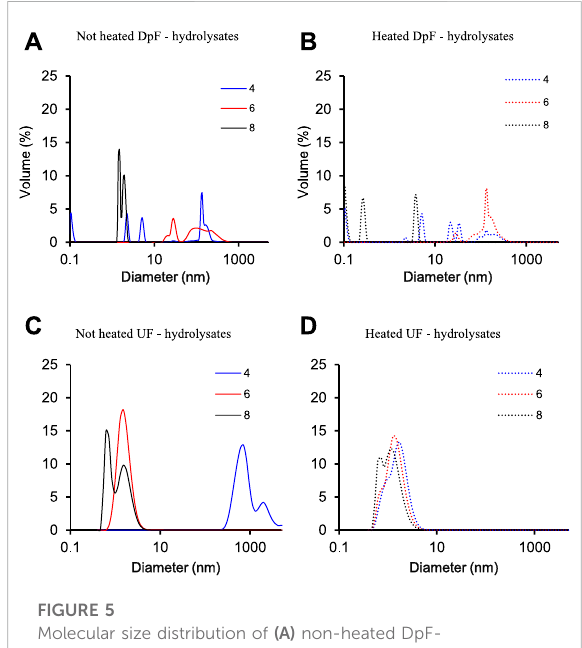
FIGURE 5 Molecular size distribution of (A) non-heated DpF- hydrolysates; (B) heated DpF-hydrolysates; (C) non-heated UF- hydrolysates; (D) heated UF-hydrolysates at pH 4, 6, and